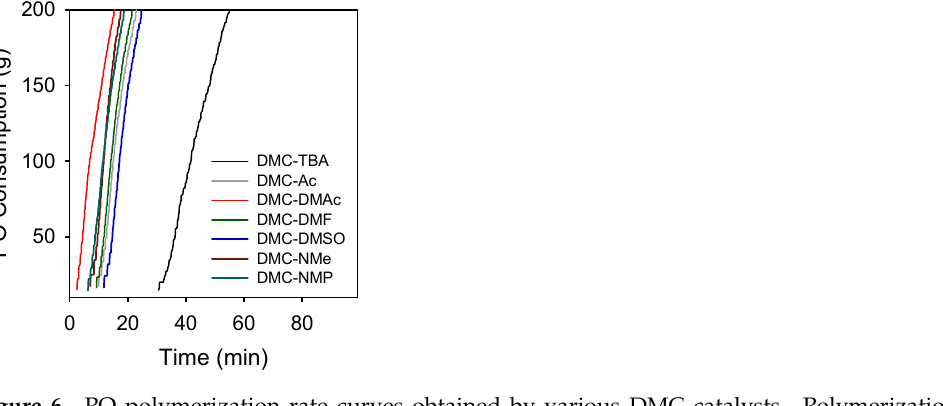
Figure 6. PO polymerization rate curves obtained by various DMC catalysts. Polymerization conditions: T p = 115 °C, PPG-400 ( F = 2) starter = 20 g, and catalyst = 100 mg. Table 3. Results of the ROP of PO using various DMC catalyst.